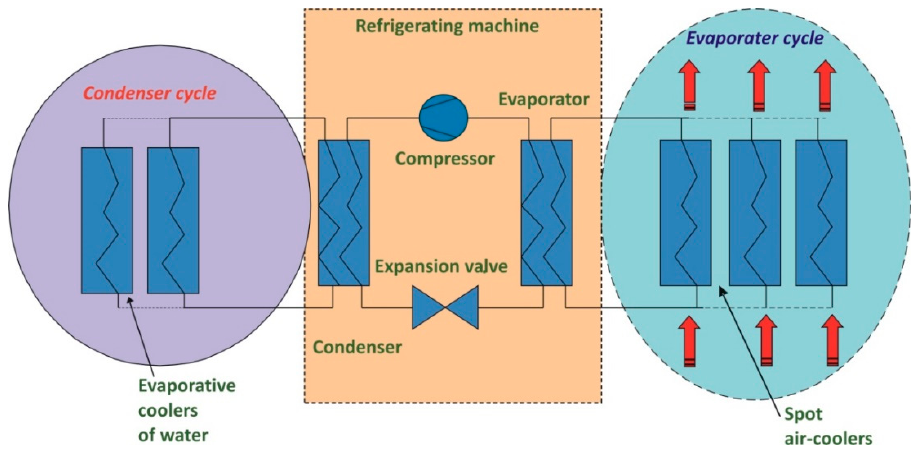
Figure 1. Schematic diagram of “a group” cooling system with an underground refrigeration plant.